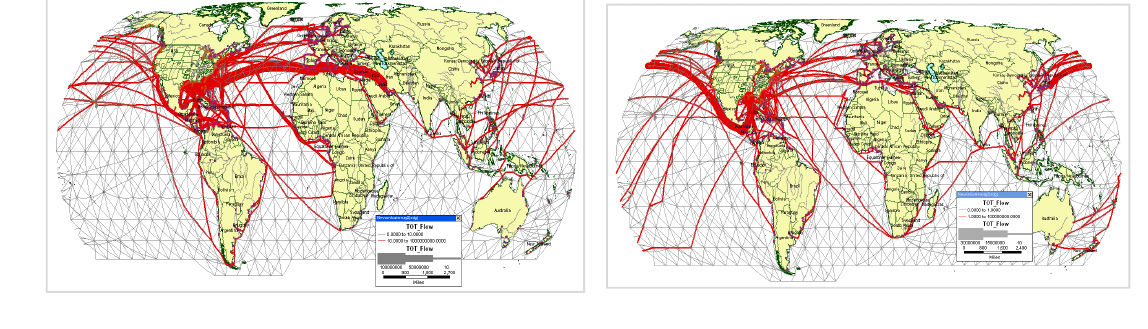
Figure 8. Most imported from or exported goods to the U.S., 2018.